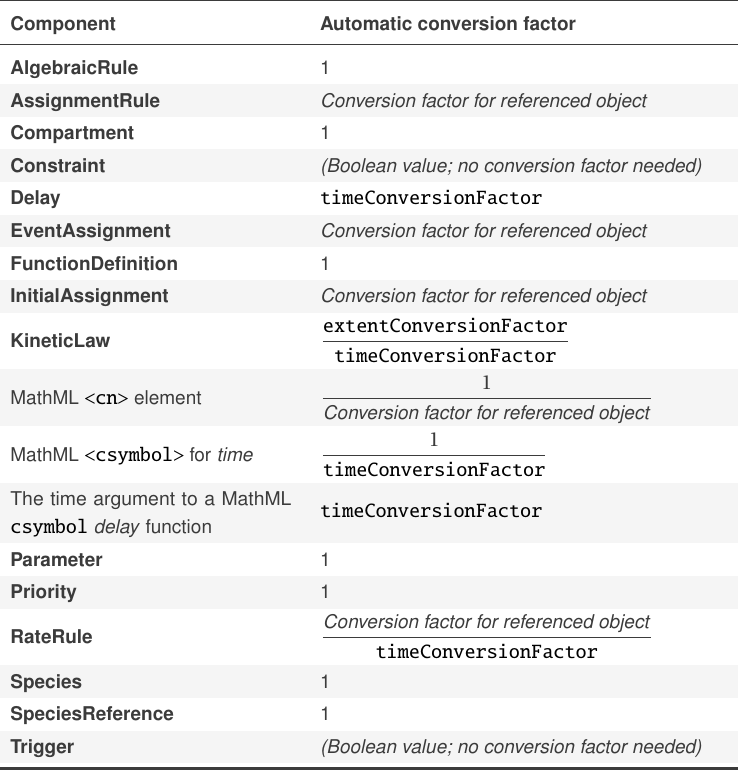
Table 4: Conversion factors used for the different components defined by SBML Level 3 Version 1